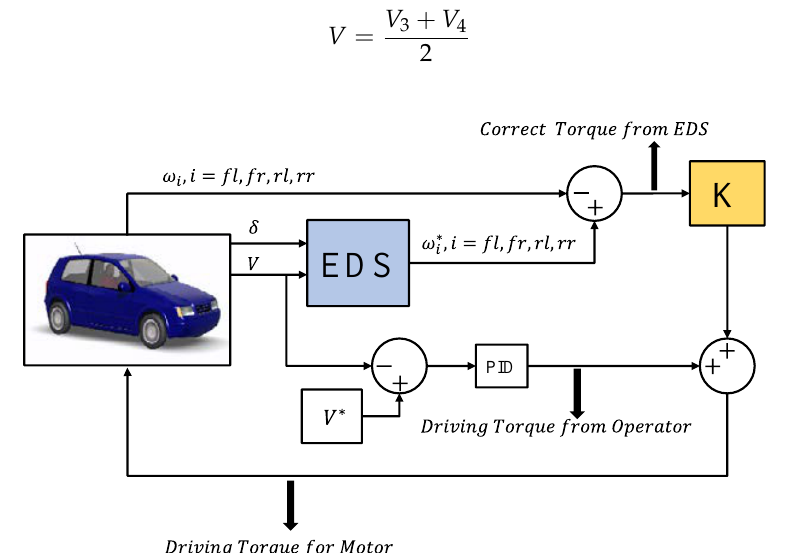
Figure 3. Proposed electronic differential system (EDS).